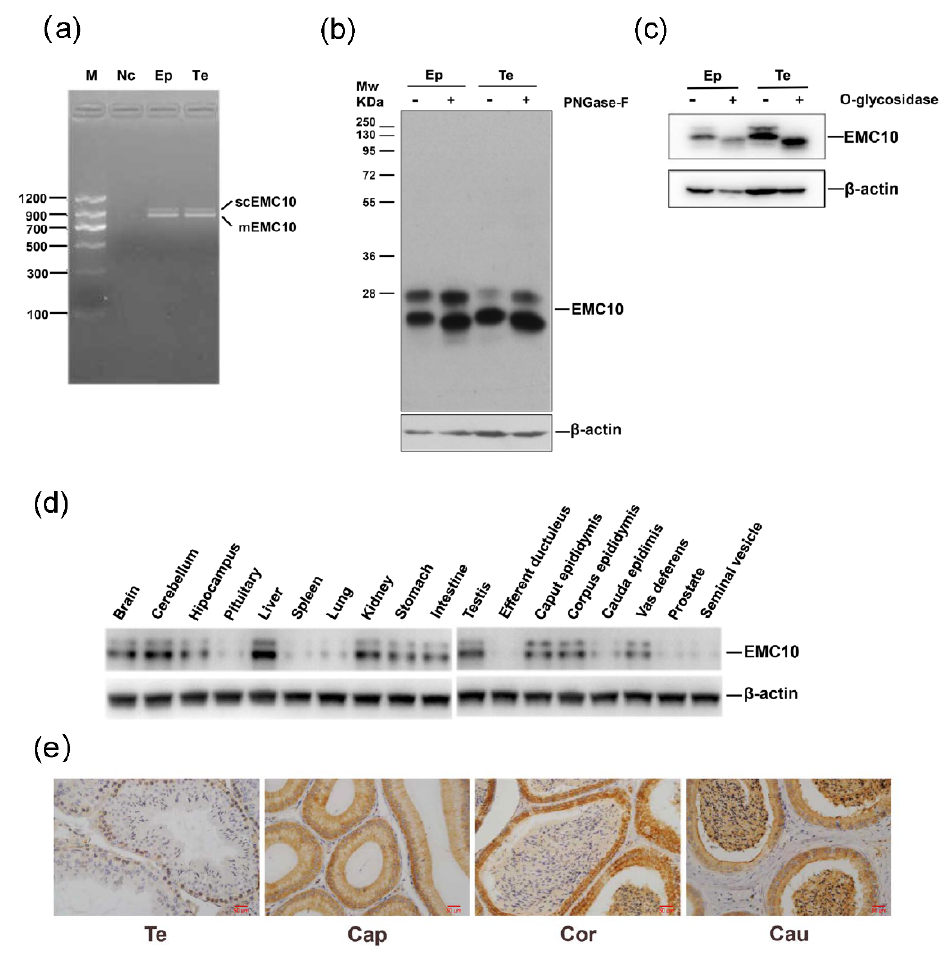
Figure 1. Characterization of EMC10 in mouse. ( a ) Two isoforms of Emc10 gene were amplified in the testis and epididymis tissues of mouse by RT-PCR and subject to agarose gel electrophoresis. ( b , c ) Protein lysate was treated with N -glycosidase-F and O -glycosidase, and then immunoblotted with EMC10 antibody. ( d ) EMC10 protein profiling in mouse. ( e ) Immunohistochemistry analysis of EMC10 in the testis and epididymis tissues of mouse. Scale bar = 50 µ m. M, marker; Nc, negative control; Te, testis; Ep, epididymis; Cap, caput epididymis; Cor, corpus epididymis; Cau, cauda epi- didymis; PNGase-F, N -glycosidase F.